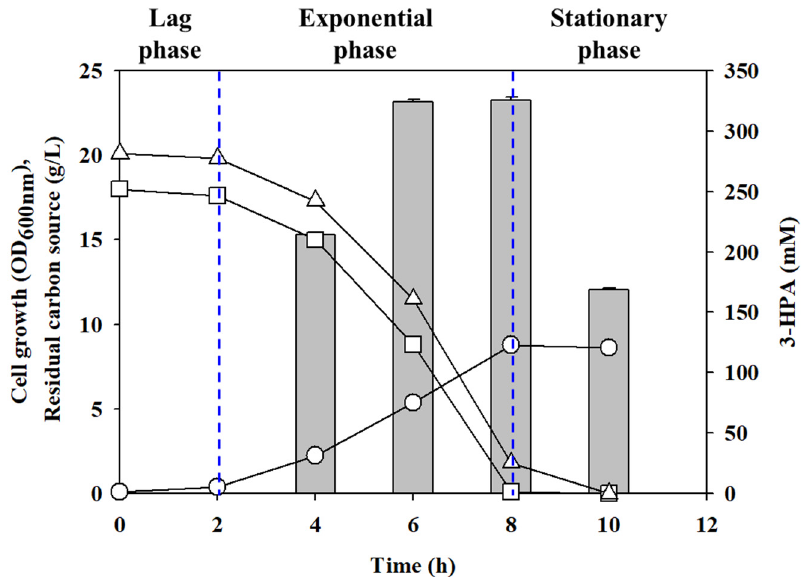
Figure 2. Batch cultivation of Lactobacillus reuteri BR201 and bioconversion of 3-hydroxypropionaldehyde during different growth phases. Open triangles, residual glycerol; open squares, residual glucose; open circles, cell growth; gray bars, 3-hydroxypropionaldehyde concentration. All results are averages from three independent experiments. Table 1. The Effect of cultivation time on the levels of residual glycerol, 3-hydroxypropionaldehyde, and 1,3-propanediol by L. reuteri BR201.